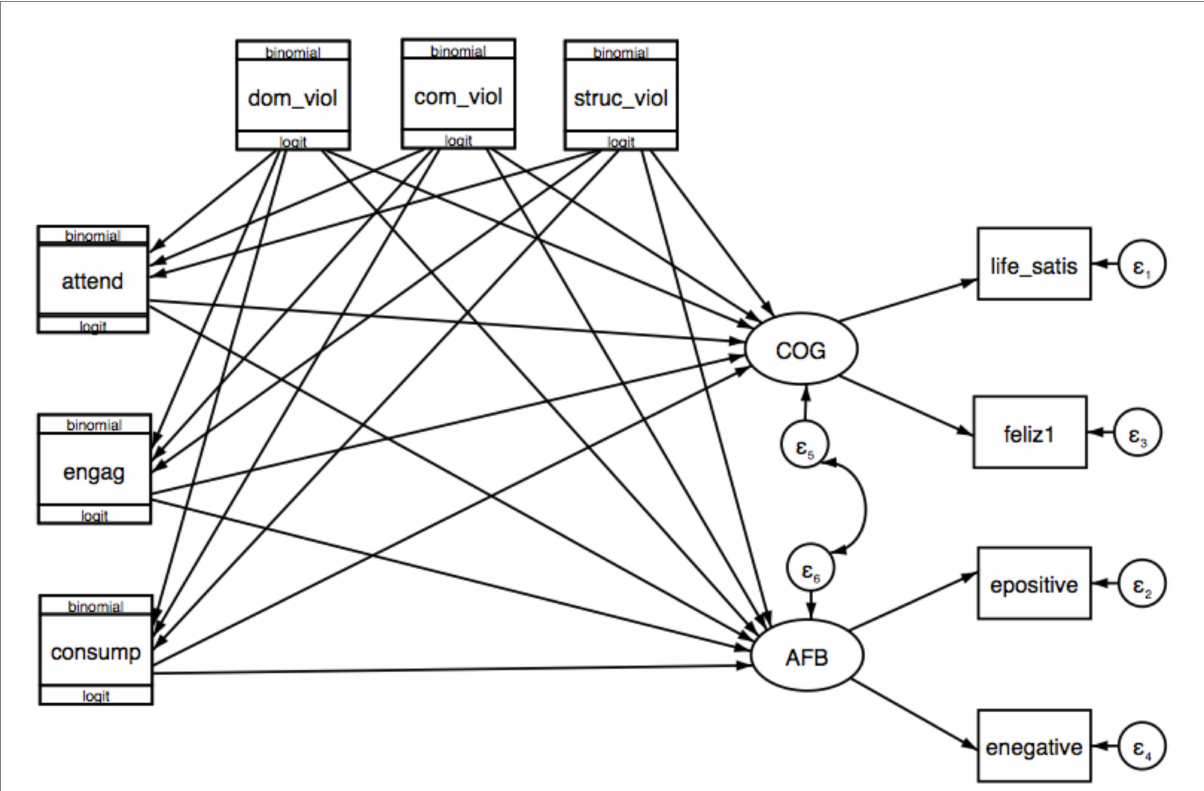
FIGURE 3 Statistical model. atten, Attendance; engag, Engagement; consump, Consumption; dom_viol, Domestic violence; com_viol, Community violence; struc_viol, Structural violence; life_satis, Life satisfaction; feliz, Happiness; epositive, Positive emotions; enegative, Negative emotions; COG, Cognitive well-being; AFB, Affective balance. This diagram does not include moderation (or interaction terms)